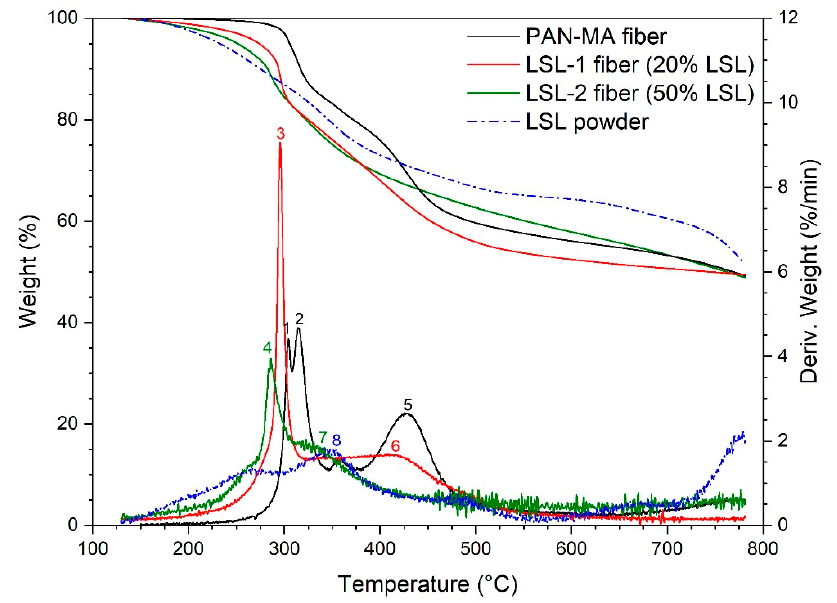
Figure 7. TGA results for LSL-containing nanofibers as compared to pure PAN-MA fibers. Numbers denote points of discussion in the text.